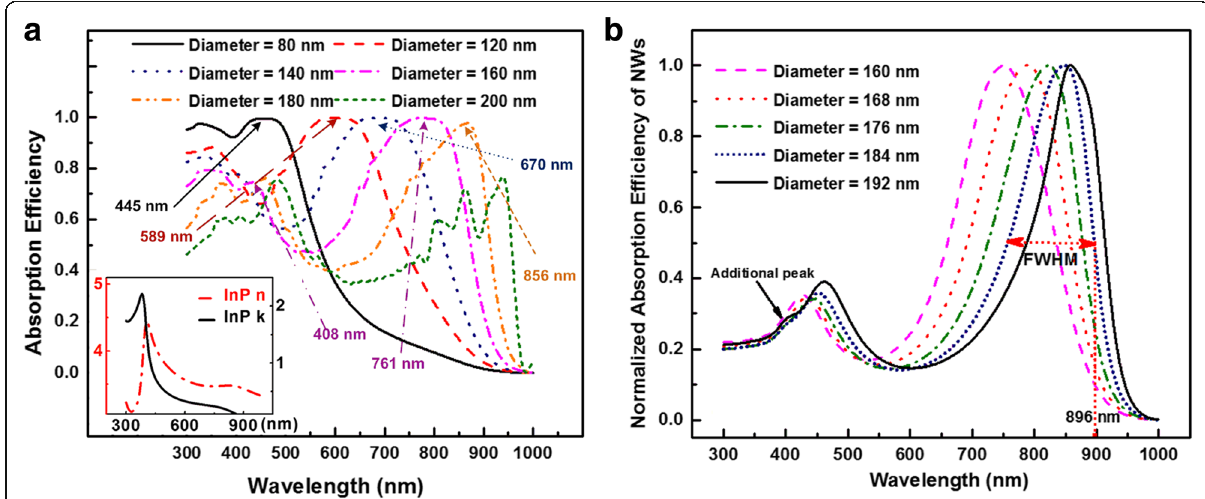
Fig. 3 Wavelength dependent absorption efficiency of InP NWs and normalized absorption efficiency. a Absorption efficiency of NWs with inset explaining the optical constants. b Calculated absorption efficiency by Mie